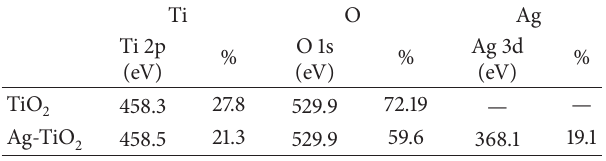
Table 1: XPS main line position and element amount (%) obtained from XPS data.